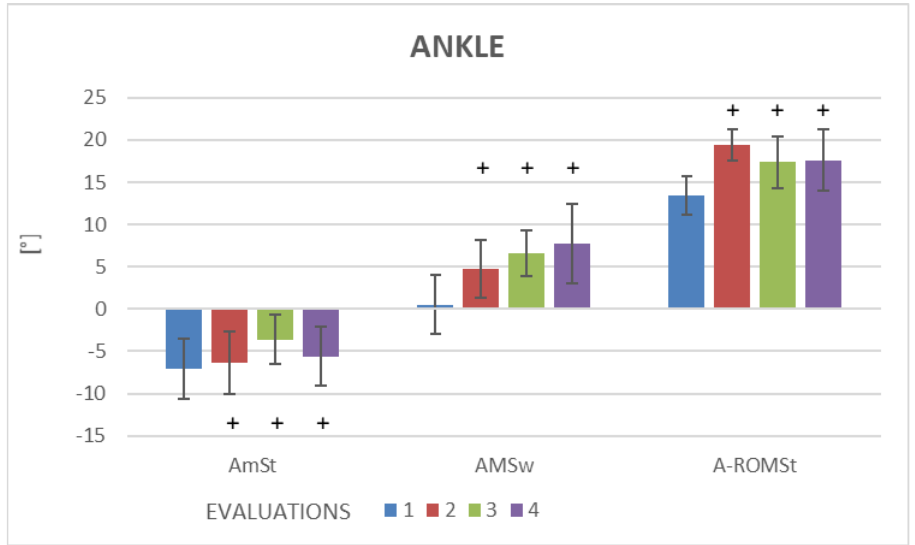
Figure 4. Outcomes of kinematics gait variables, for ankle joint of the paretic side, expressed as median values and the interquartile range. + Statistically significant difference in comparison to baseline ( p < 0.05). AmMSt = minimum angle of ankle plantar flexion in stance; AMSw = maximum angle of ankle dorsiflexion in swing; A-ROMst = range of motion of ankle in stance.